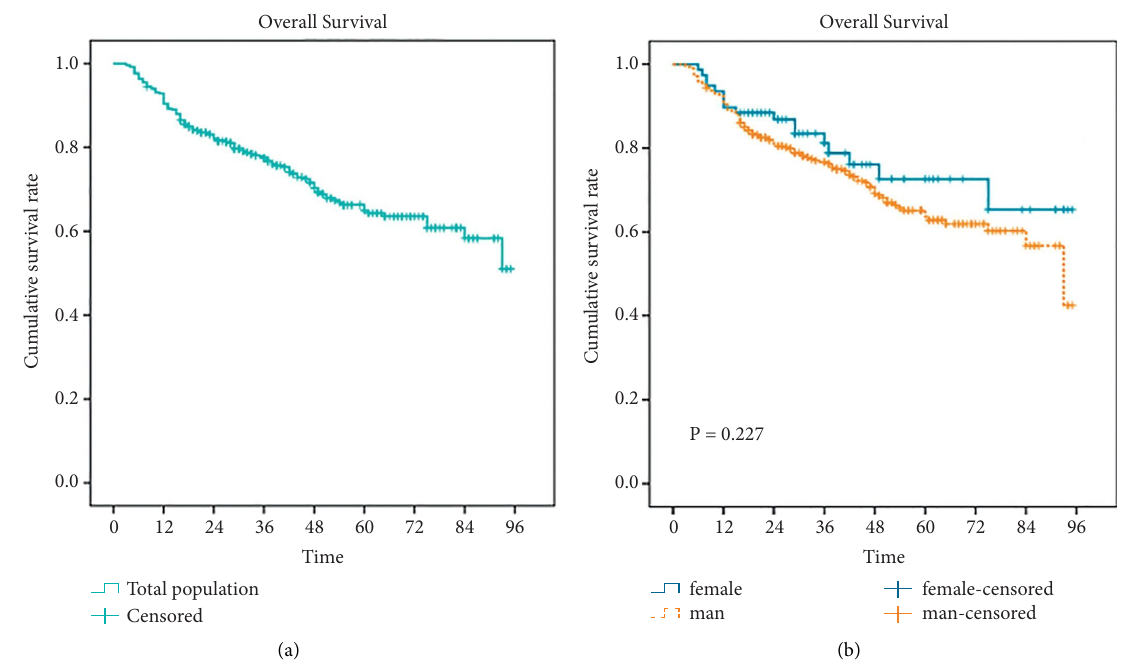
Figure 2: The overall cumulative survival rate of postoperative mortality in patients with hepatitis B-related HCC patients (a). The cumulative survival rate of men and women subgroups